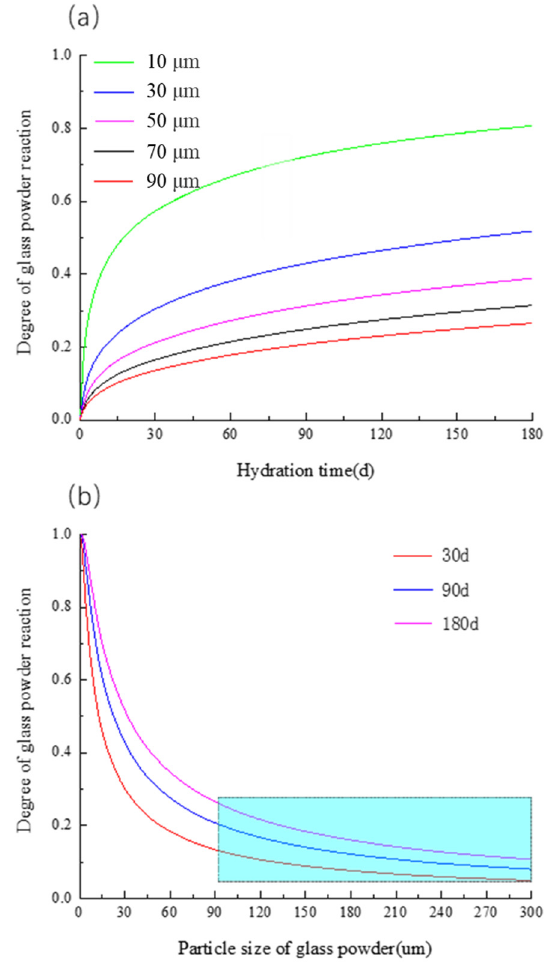
Figure 6. Effect of glass particle size on degree glass powder reaction ( a ) Glass powder reactivity— time curve of different glass powder sizes ( b ) Glass particle size and glass powder reactivity curve.